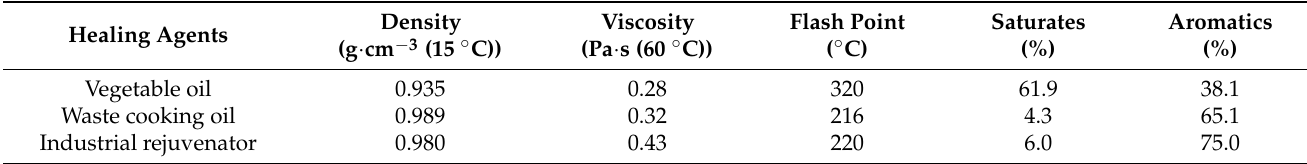
Table 1. Properties of the three healing agents.